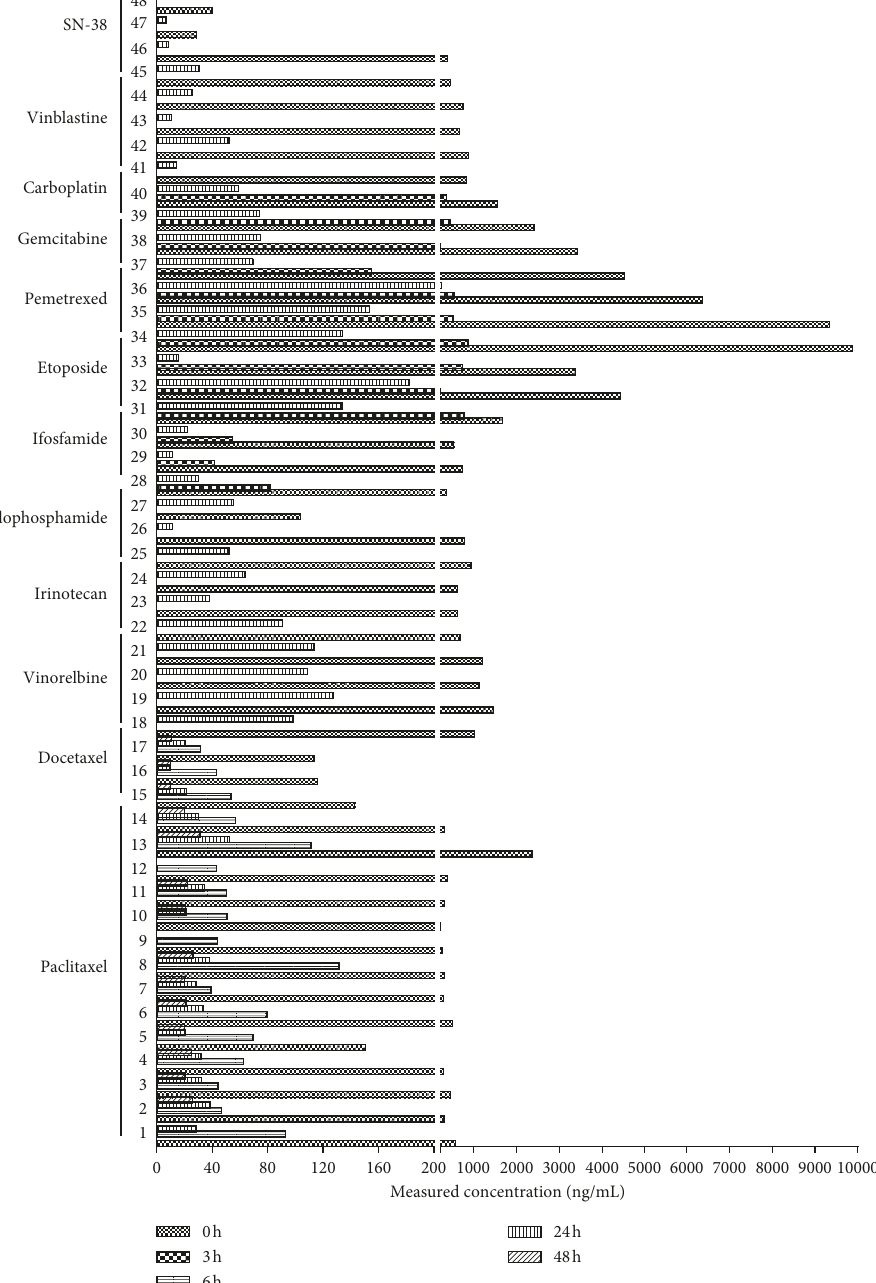
Figure 3: The quantification results of 132 plasma samples from 48 lung cancer